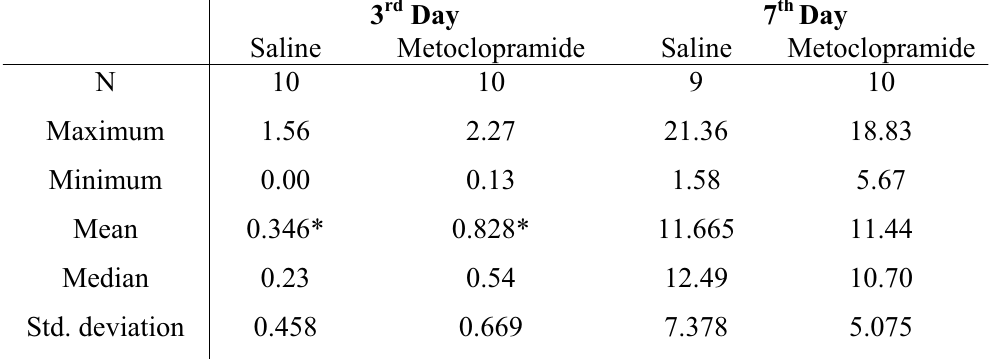
TABLE 4 - Breaking tensile strength of animals sacrificed on the third and seventh days expressed in Newtons